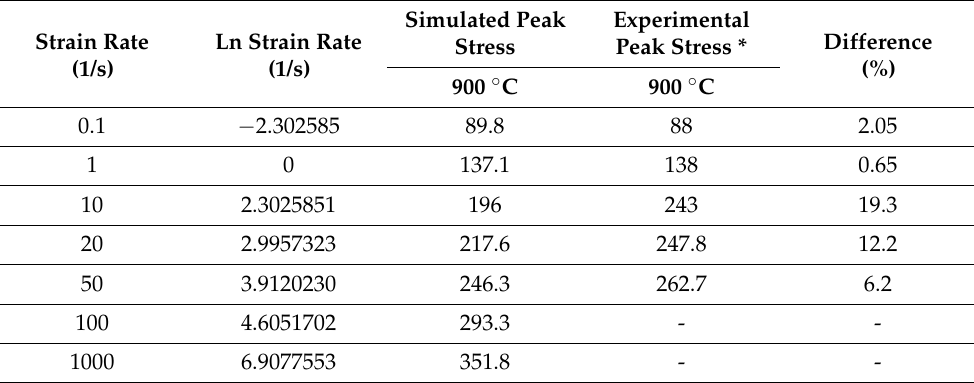
Table 3. Peak flow stress obtained under DEFORM-3D simulation and the Gleeble experiment for